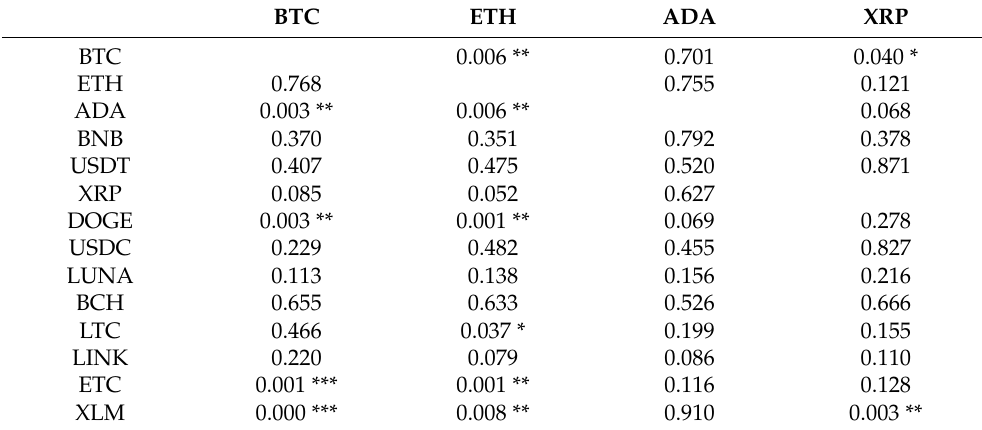
Table 5. Granger Causality Test.